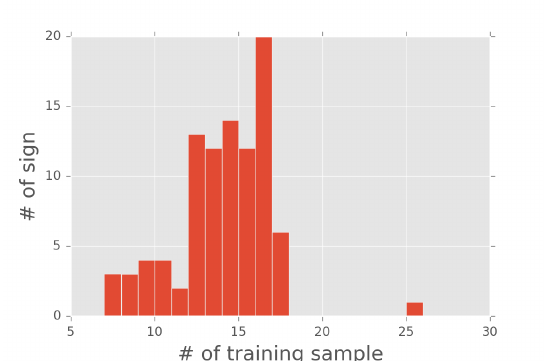
Figure 9. Histogram of the number of training samples per sign of the DSGS dataset.